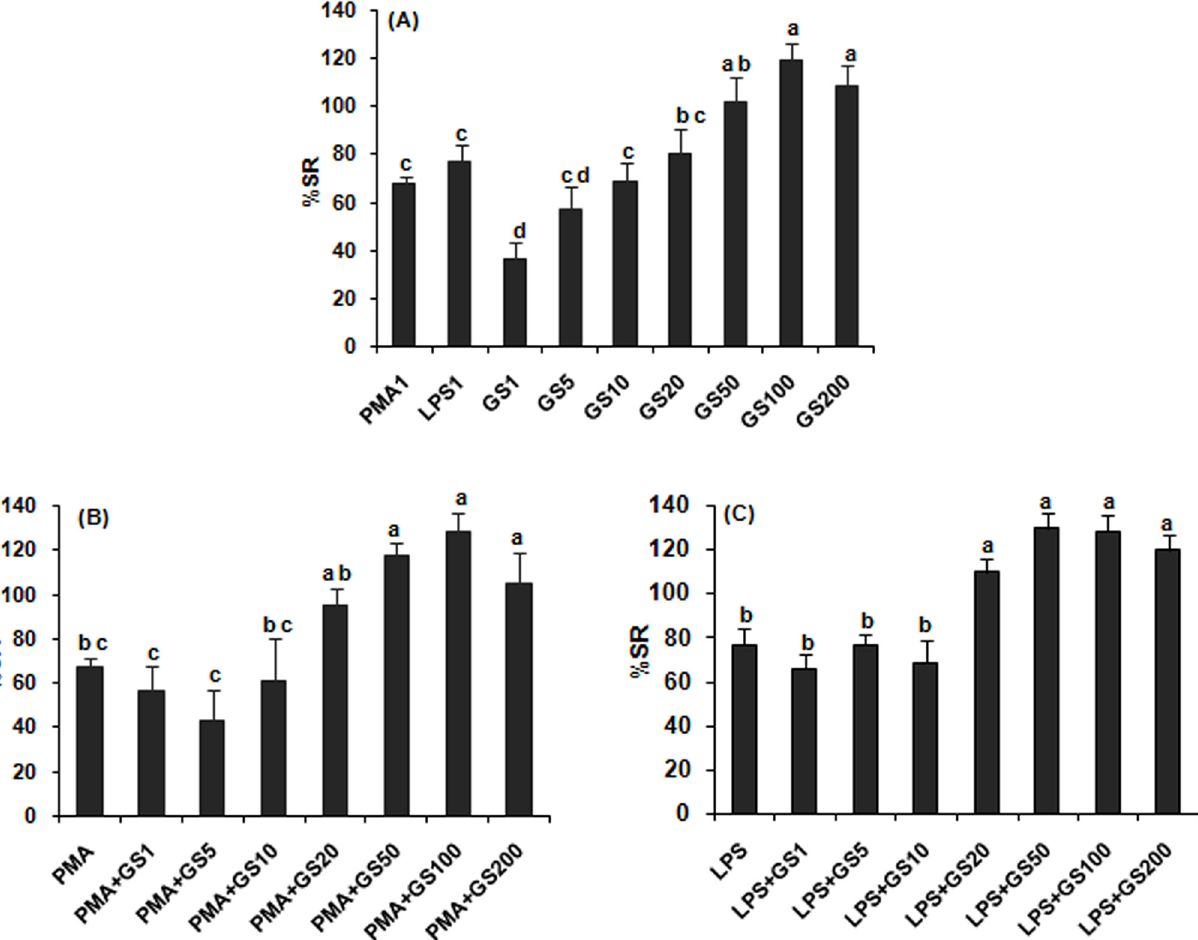
Fig 1. NBT reduction in rat peritoneal macrophages in vitro treated with Gymnema sylvestre leaf extract alone (A) and in combination with PMA 1 μ g/ml (B) and LPS 1 μ g/ml (C). GS1 – GS200 represent concentration of extract, 1 – 200 μ g/ml, respectively. Bars bearing same alphabet do not differ significantly. [Treatment effect ANOVA: F = 10.69 (8,18); p < 0.05, (B) F = 7.57 (7,16); p < 0.05, (C) F = 14.27 (7,16); p <